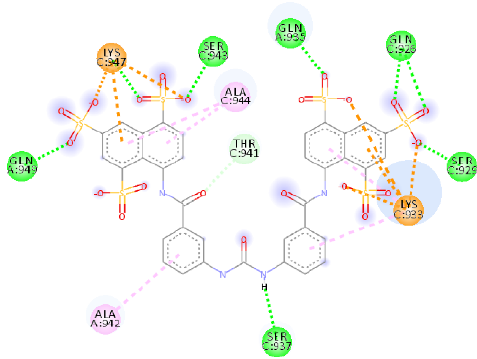
Figure 4. Calculated 2D interactions for NF 023 hydrate in complex with SARS-CoV-2’s HR1 do- main.